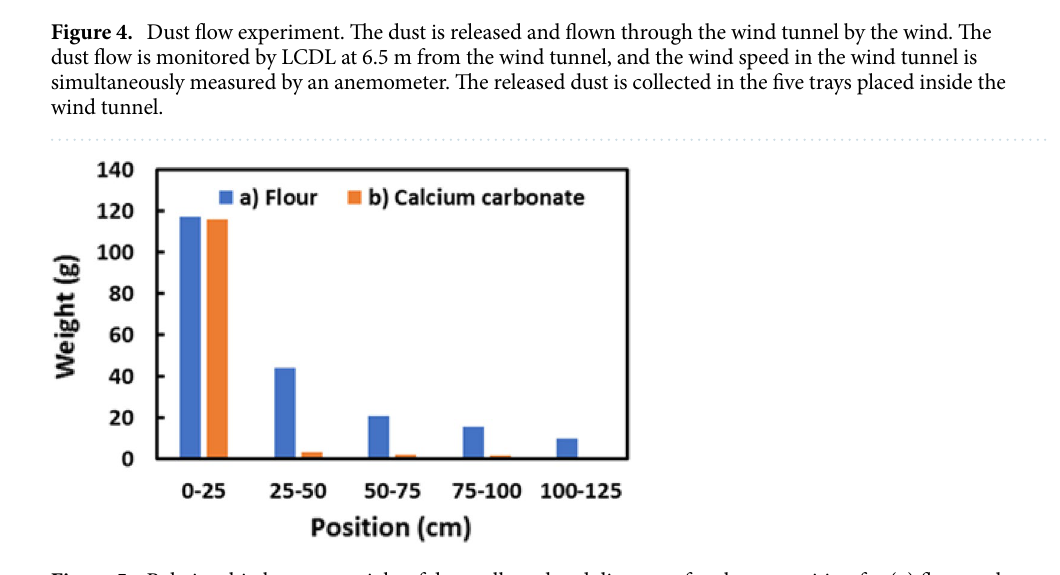
Figure 5. Relationship between weight of dust collected and distance of each tray position for ( a ) flour and ( b ) calcium carbonate particles. Most of the calcium carbonate particles are collected near 0 cm of the release position, while significant flour particles are collected up to 125 cm away from the release